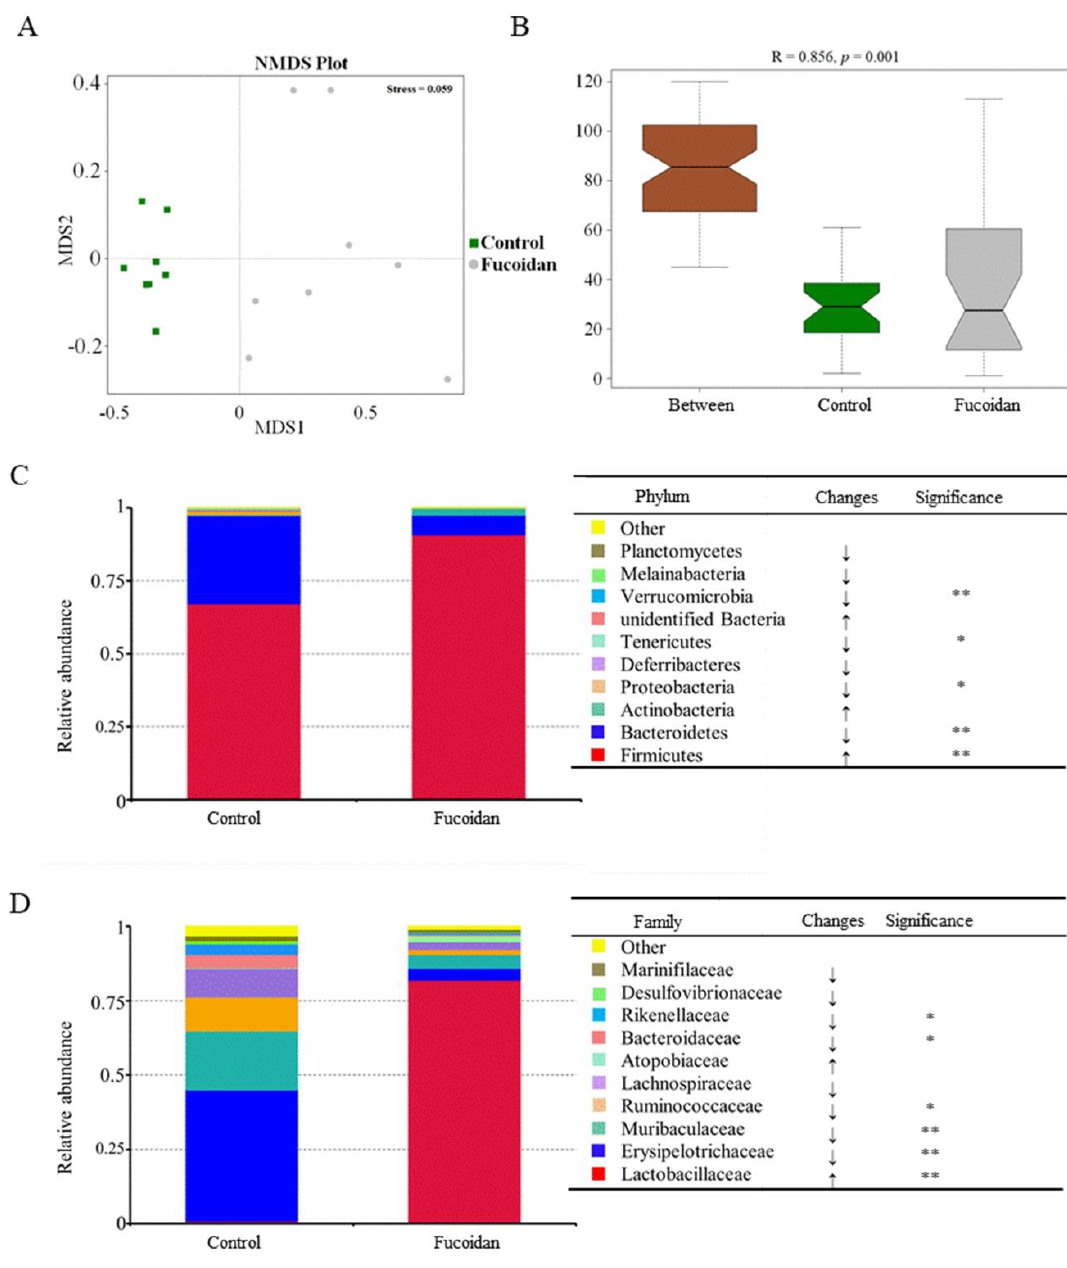
Figure A2. Bacterial community analysis. ( A ) Nonmetric multidimensional scaling (NMDS) and ( B ) ANOSIM analysis. The top 10 ( C ) phyla and ( D ) families. ↑ , the genera increased by fucoidan supplementation in mice after 10 weeks; ↓ , the genera decreased by fucoidan supplementation in mice after 10 weeks. * p < 0.05, ** p < 0.01.